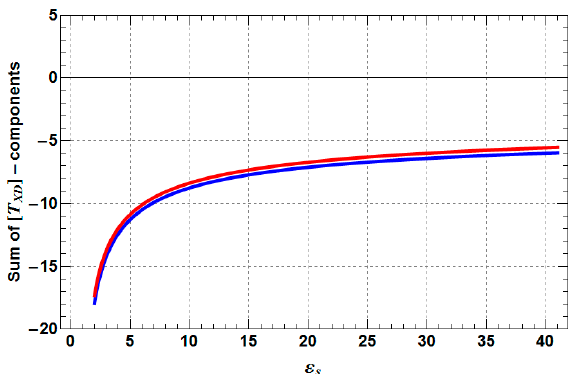
Figure 17. Sensitivity of coherency matrix combination T XD22 + T XD33 (blue) (dB) with the dielectric of